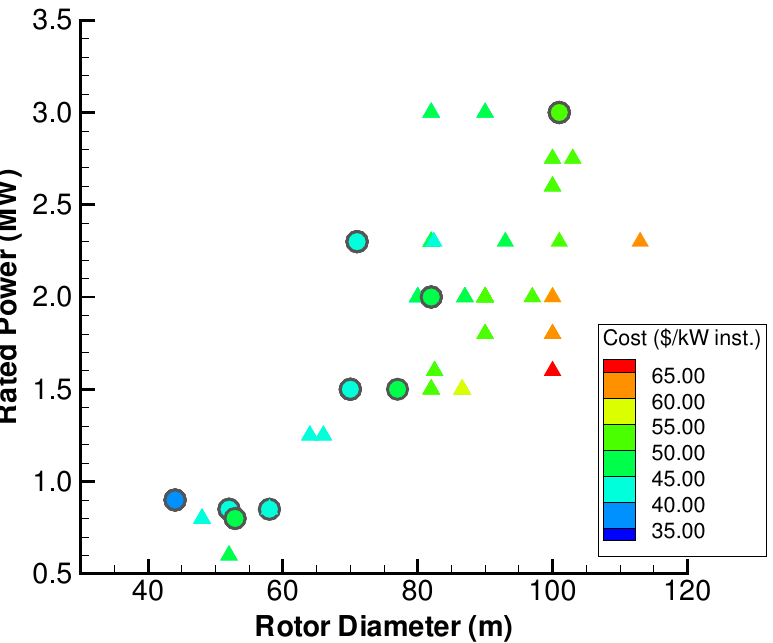
Figure 21. Rated powers and rotor diameters of the best tradeoff turbines (circles) and other available commercial turbines